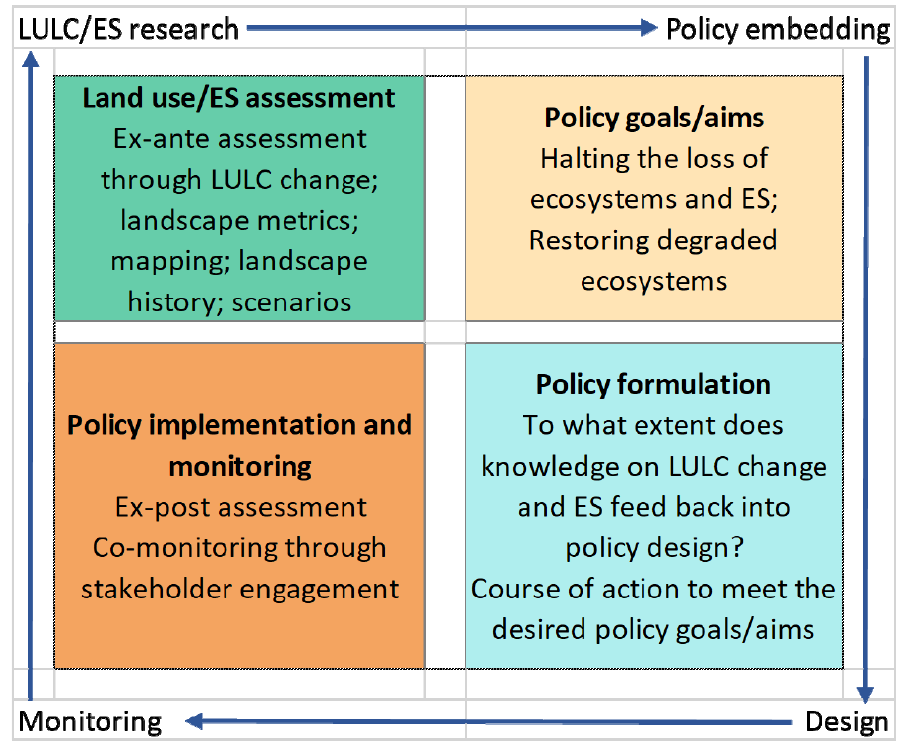
Figure 3 Embedding linkages between land use and ecosystem services into the policy cycle. Figure 3. Embedding linkages between land use and ecosystem services into the policy